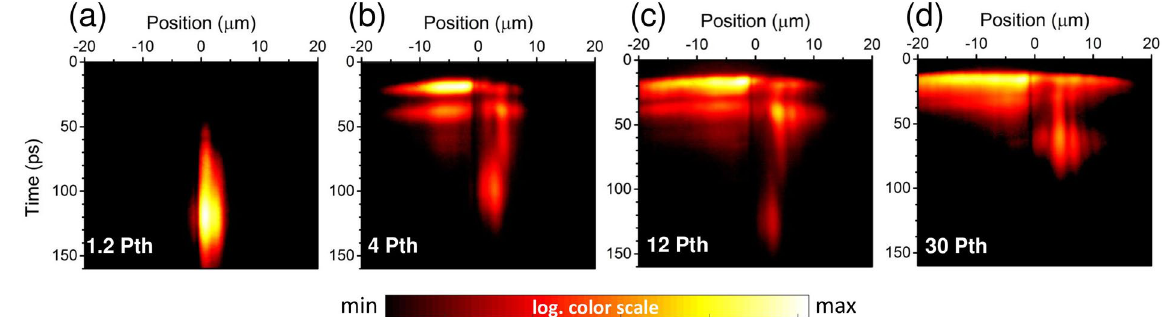
Figure 2. Time-resolved spatial dynamics of a polariton condensate. Recorded-time resolved along the line indicated in Fig. 1 are presented for several pumping powers. ( a ) 1.2 P th , where long-lasting localized polariton emission is observed ( b ) 4 P th , onset of polariton emission bursts, ( c ) 12 P th and ( d ) 30 P th , merging of the pulses at highest pumping levels. The pseudo-color scale is